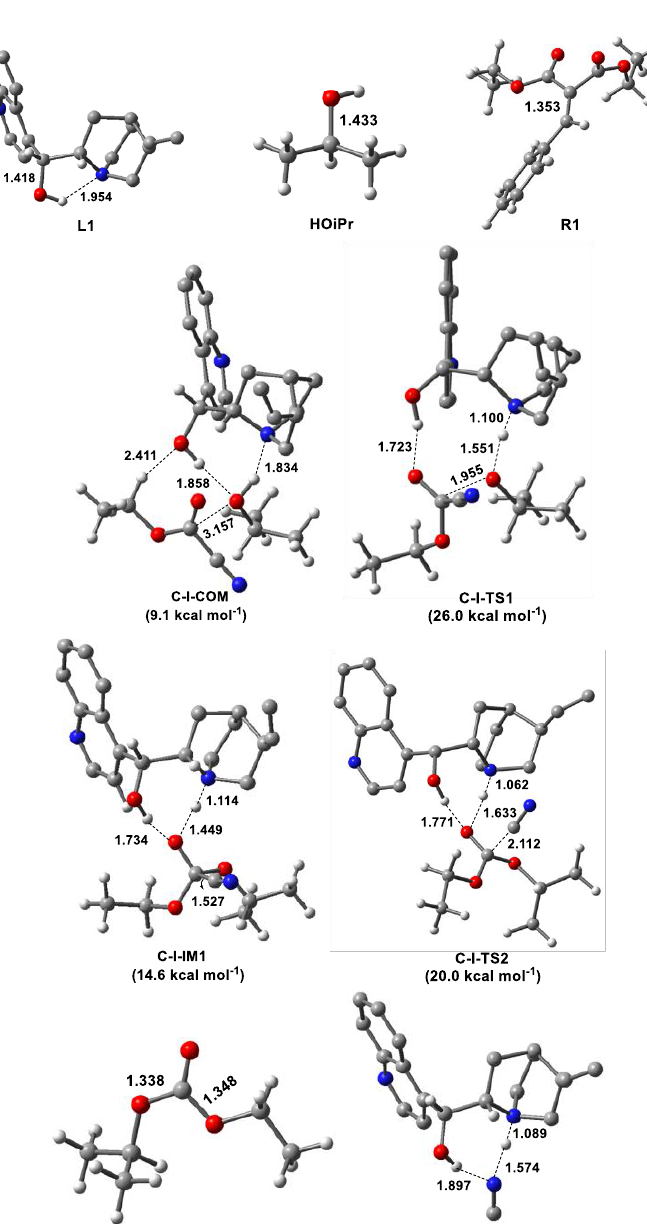
Figure 2. Optimized geometries of reactants (R1 and HOiPr), cinchona alkaloid (L1), molecular complex (C-I-COM), transition states (TSs) (C-I-TS1 and C-I-TS2) and intermediates (C-I-IM1–C-I-IM3) for the HNC formation catalyzed by cinchona alkaloid (some H atoms in cinchona alkaloid are omitted for clarity) and their relative Gibbs free energies. The intermolecular distance is in Angstroms (Å). The color definitions of atoms are red = oxygen, blue = nitrogen, gray = carbon and white = hydrogen.